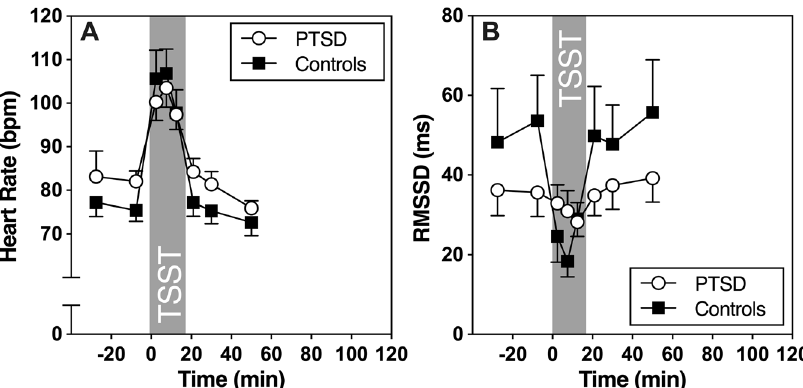
Fig. 2 Heart rate and heart rate variability reactivity to acute psychosocial stress. a Heart rate (HR) and b heart rate variability (HRV; measured as RMSSD) before and after TSST. Data points represent bins of 5-min intervals. Figure shows mean and SEM.